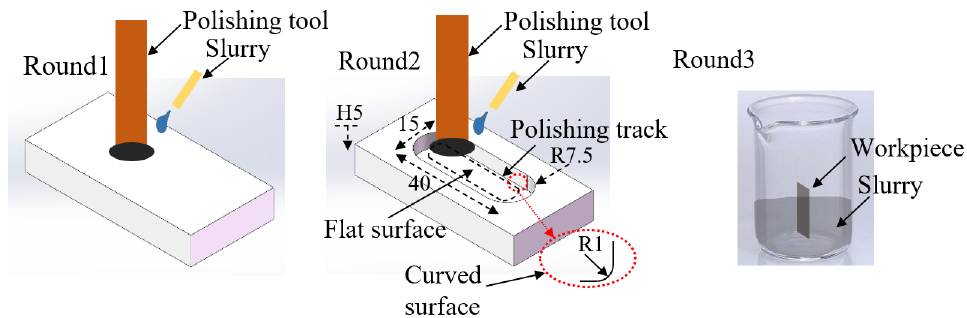
Figure 3. Experimental workflow (unit: mm).